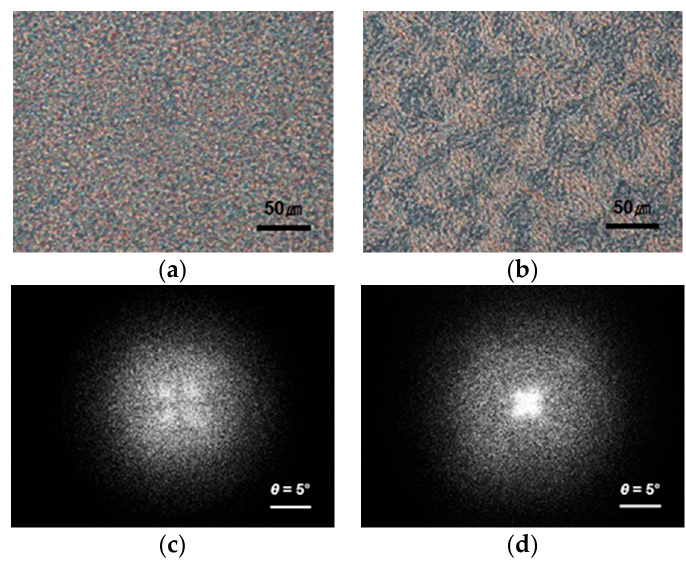
Figure 5. Polarized optical micrographs and the corresponding H v light scattering patterns of blend samples crystallized isothermally at 155 °C for 1 h after annealing at 265 °C for ( a ) and ( c ) t s = 8 min; ( b ) and ( d ) t s = 30 min.